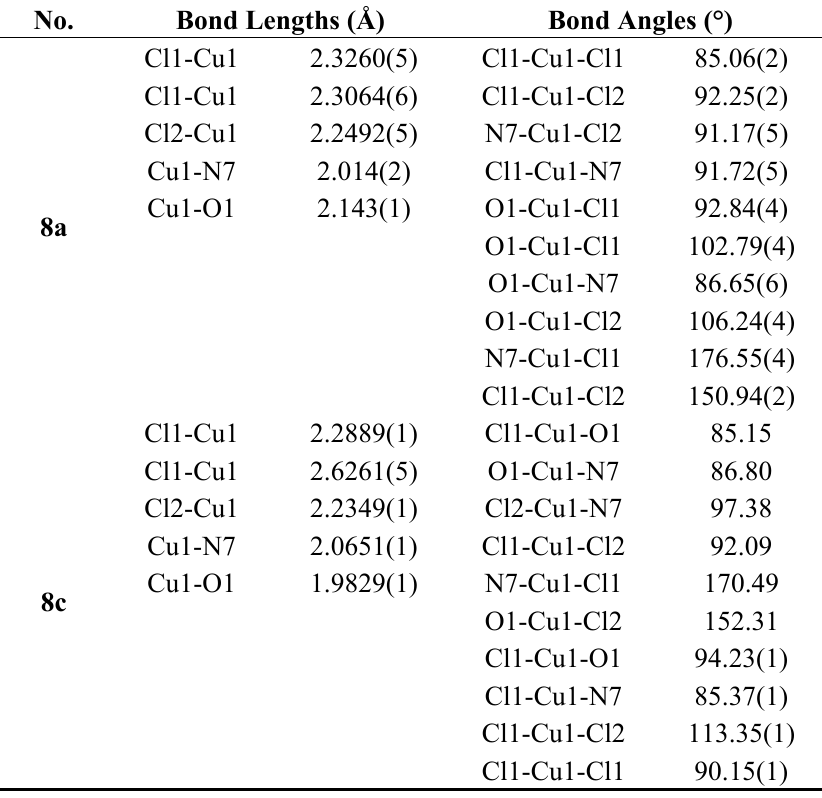
Table 5. Selected bond lengths and bond angles in copper complexes 8a and 8c .